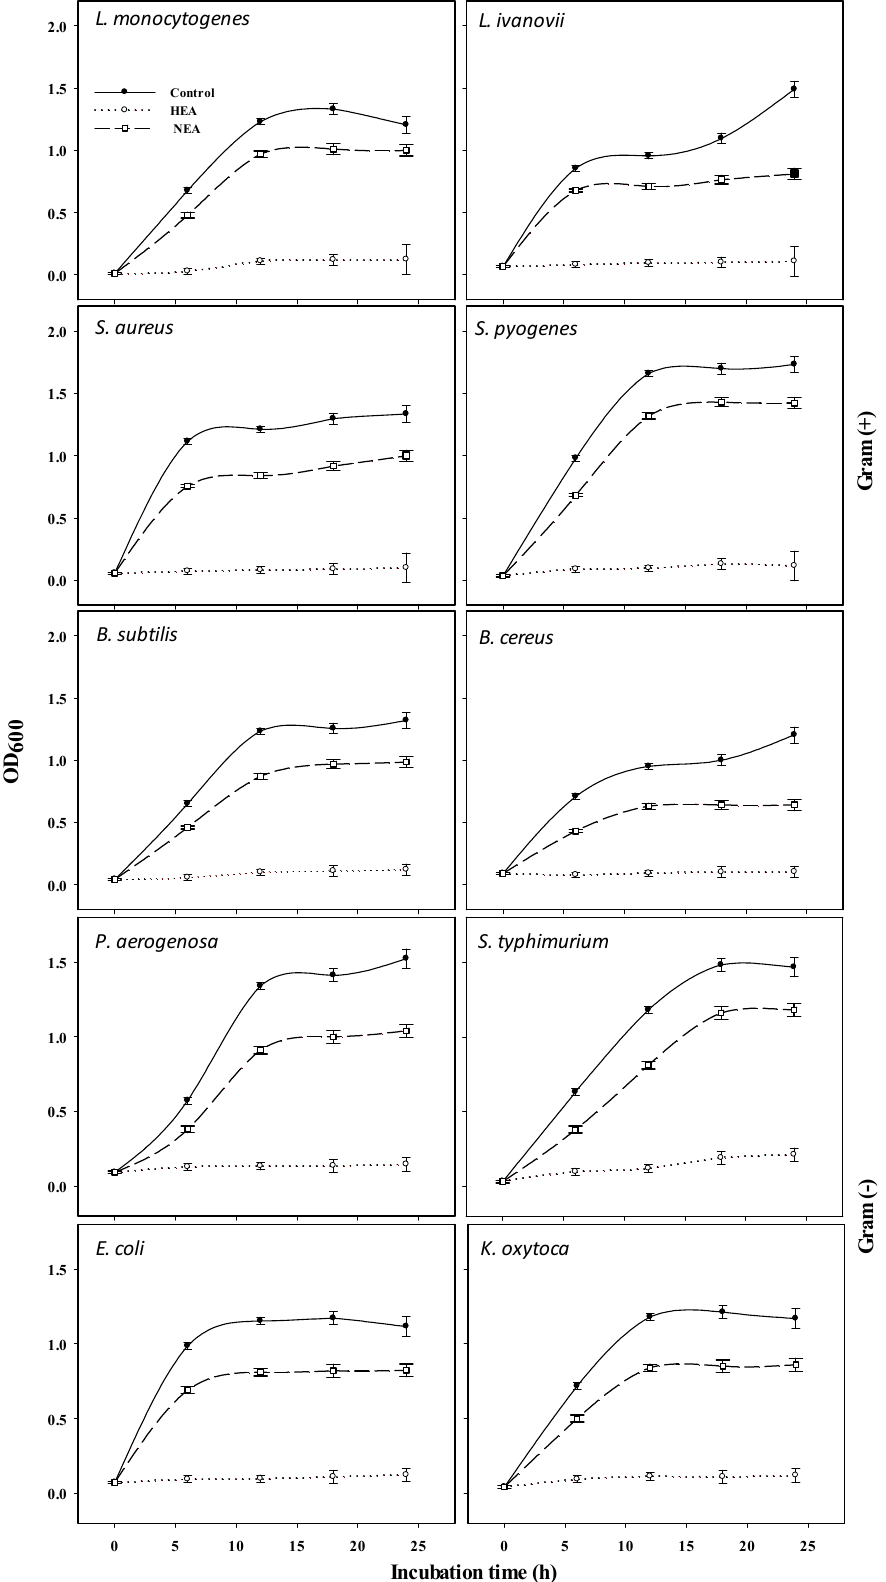
Figure 4. Twenty-four hour growth curves of six pathogenic Gram ( + ) and four pathogenic Gram ( − ) in the presence of the value minimum inhibitory concentration (MIC) of HEA.